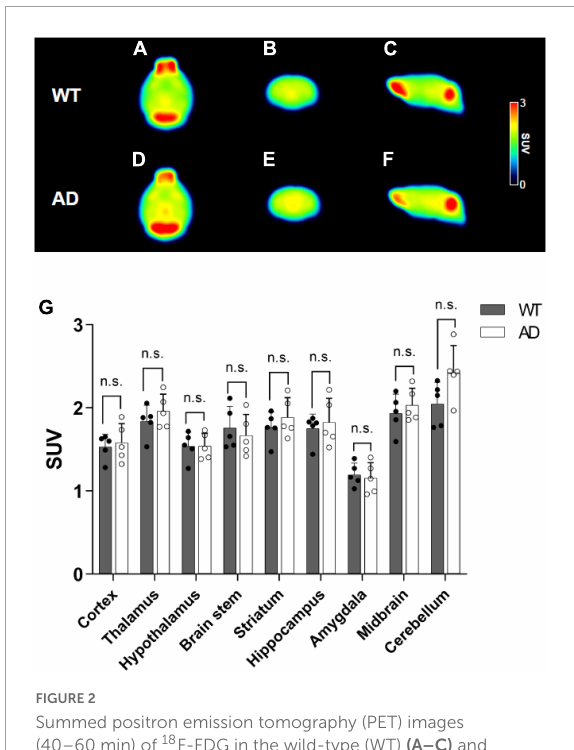
FIGURE2 Summed positron emission tomography (PET) images (40–60 min) of 18 F-FDG in the wild-type (WT) (A–C) and Alzheimer’s disease (AD) groups (D–F) . In PET images, the columns from left to right show the axial, coronal, and sagittal views. Comparison of the standardized uptake values (SUVs) in terms of the target regions (G) . Data are presented as the mean ± SD ( n =